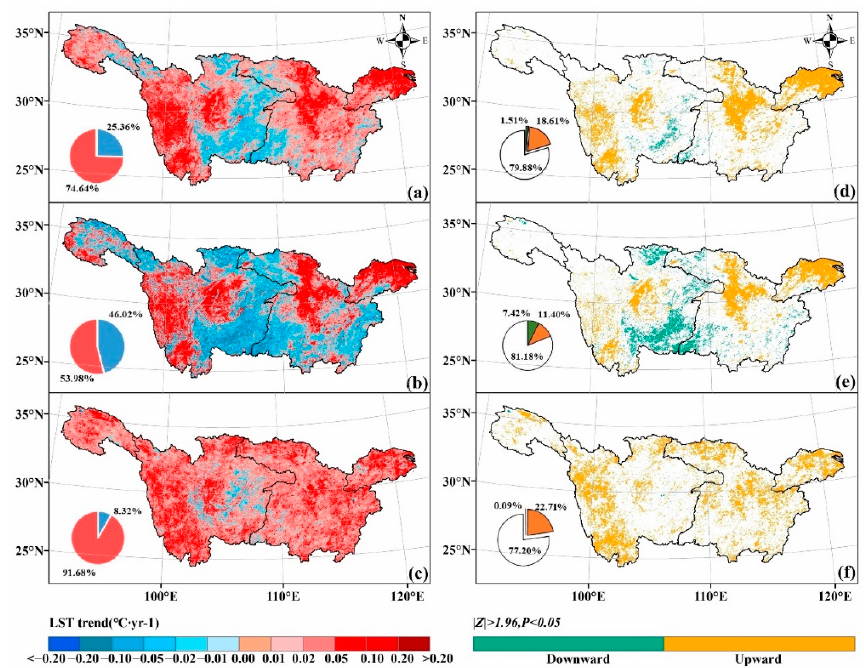
Figure 3. Trend variation and its significance of LST from 2003 to 2021: interannual ( a ) and ( d ); day time ( b ) and ( e ); and night time ( c ) and ( f ). The inset pie charts show the percentage of area with an uptrend and downtrend, respectively ( a – c ), and the percentage of area with a significant uptrend, significant downtrend and insignificant change, respectively ( d – f ).